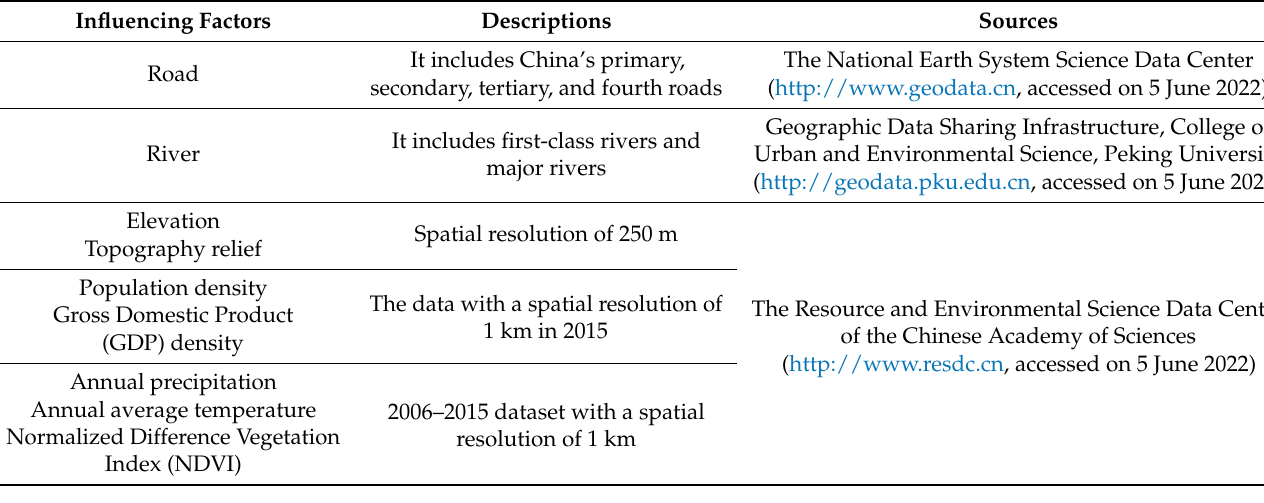
Table 1. Descriptions of influencing